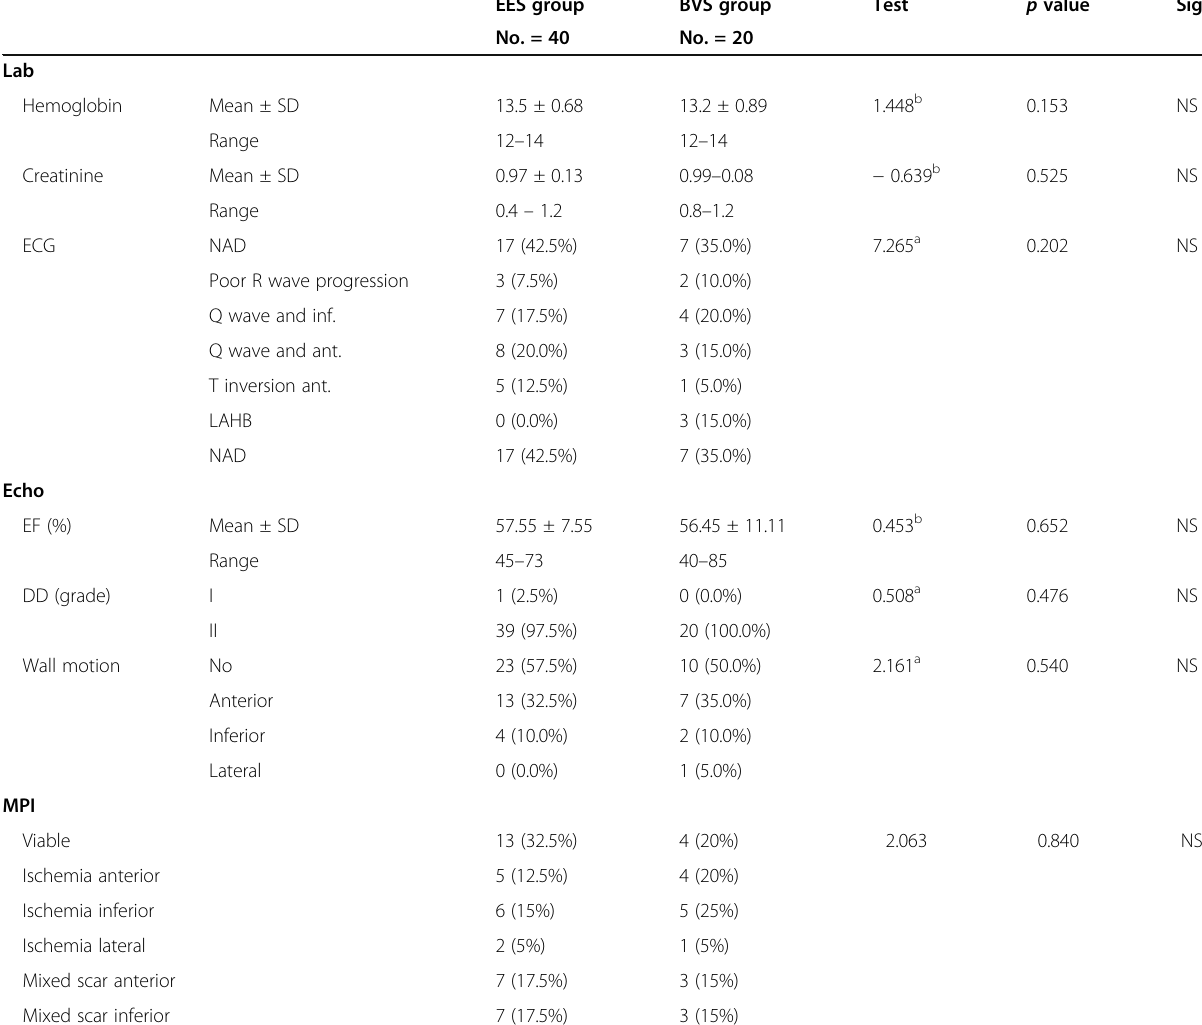
Table 3 Lab, echocardiographic data, and myocardial perfusion index (MPI) on